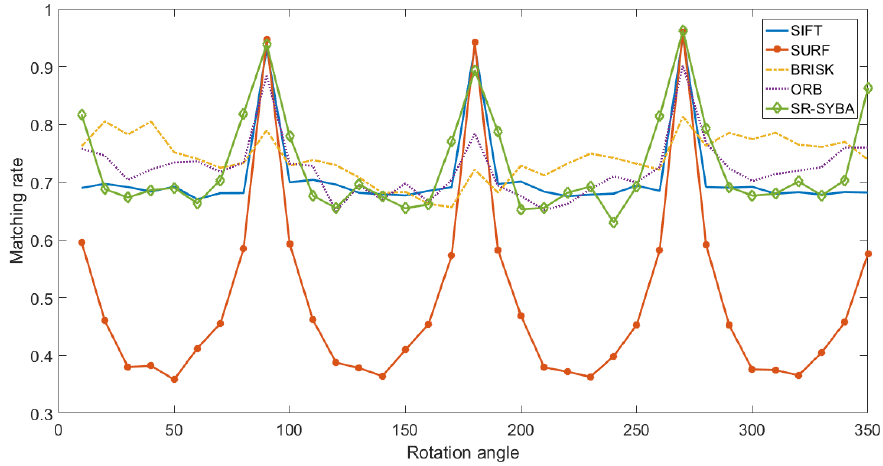
Figure 13. Comparison with scaling variations.